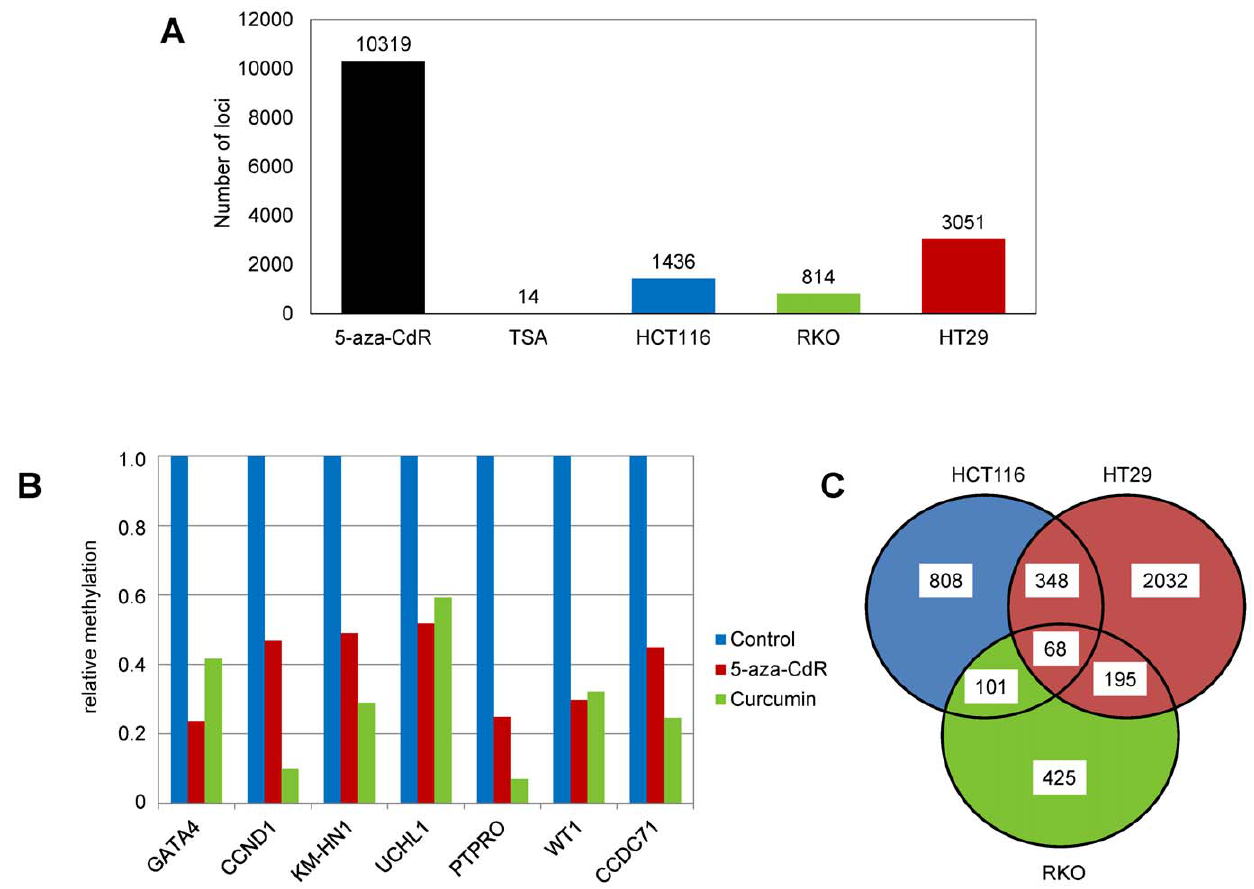
Figure 4. Validation of the curcumin-mediated methylation changes in CRC cell lines. (A) To validate the changes in DNA methylation, the samples were re-analyzed with an Infinium microarray using independently bisulfite modified genomic DNA. The figure represents the number of CpG loci that showed CpG methylation changes with a Db -value of $ 0.1 in both experiments. 5-aza-CdR and TSA treated cells were used as positive and negative controls of validation. (B) Quantitative MSP (qMSP) was performed to validate the methylation changes in HCT116. Relative methylation was calculated by normalization of the methylation status of curcumin and 5-aza-CdR treated cells to controls. (C) The Venn diagram shows that CpG methylation changes overlap between HCT116, RKO and HT29 after the treatment with